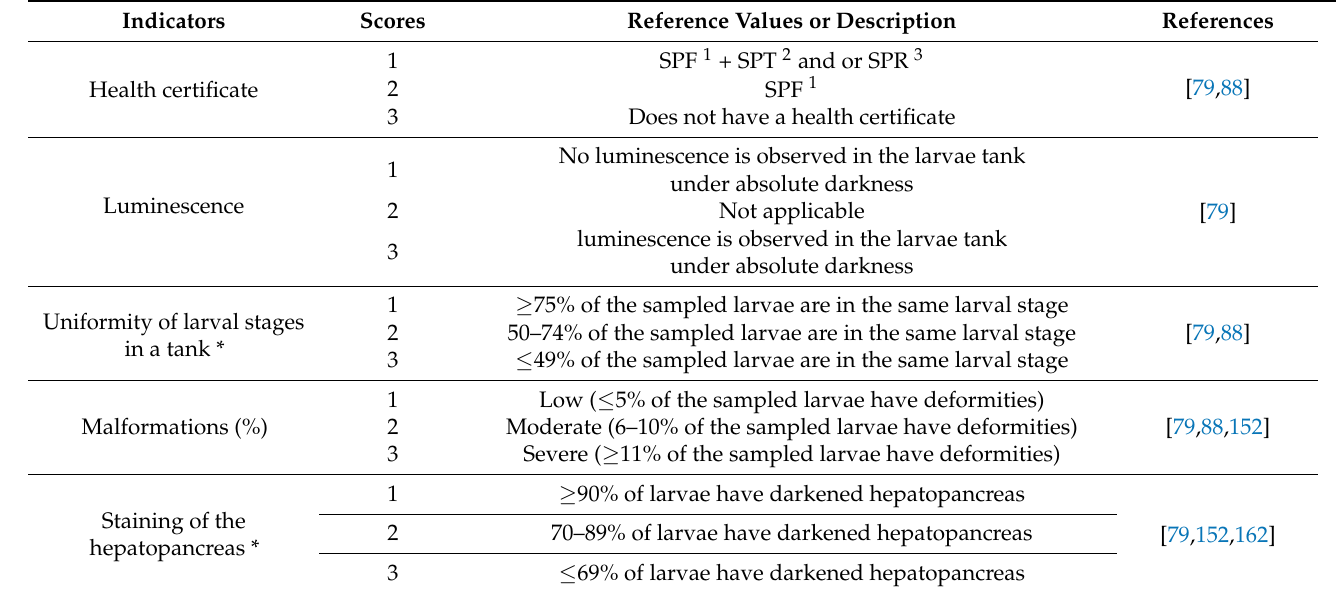
Table 7. Health indicators for larvae and postlarvae of Penaeus vannamei